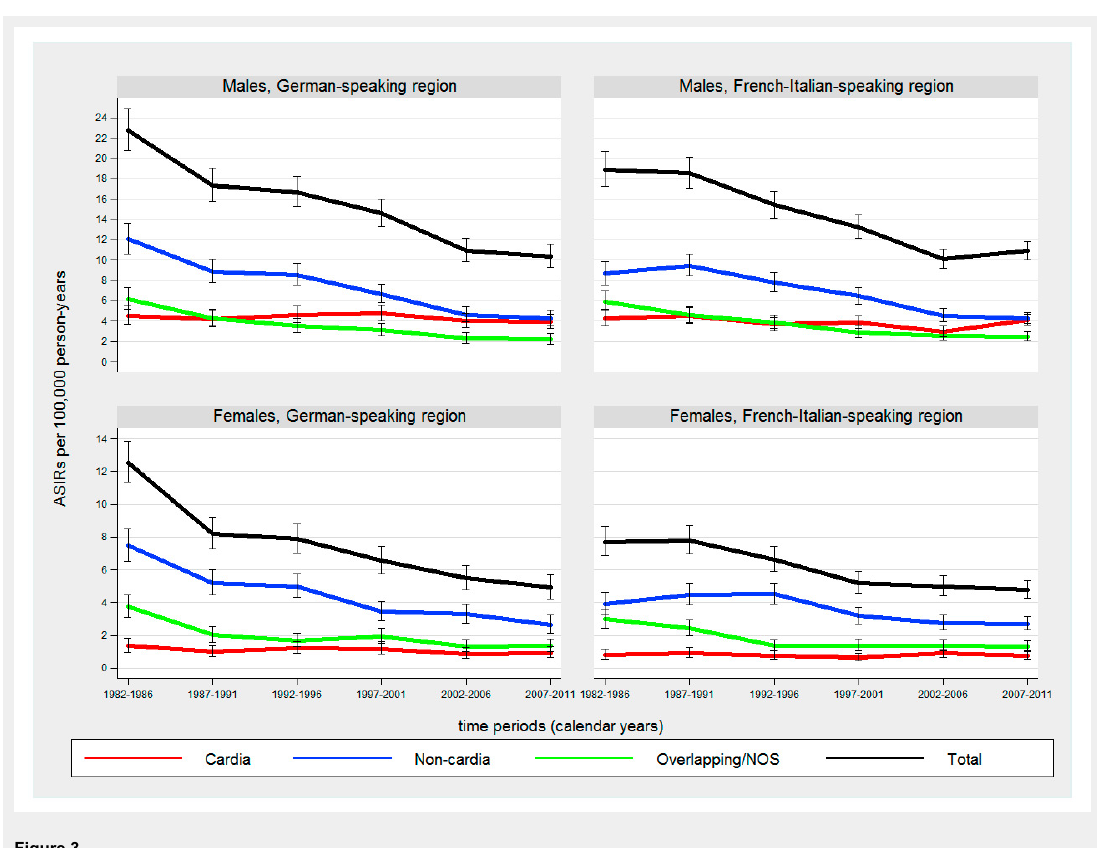
Time trends in age-standardised incidence rates (ASIRs) (European standard population) of gastric cancer by sex, anatomical location and language region from 1982 to 2011. NOS = not otherwise